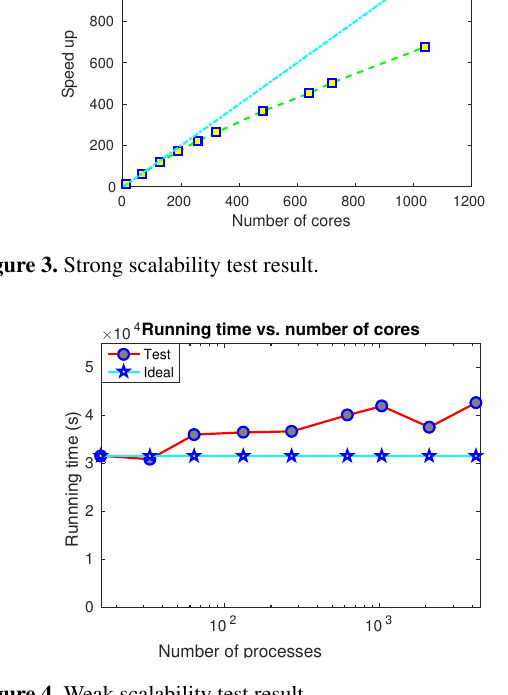
Figure 4. Weak scalability test